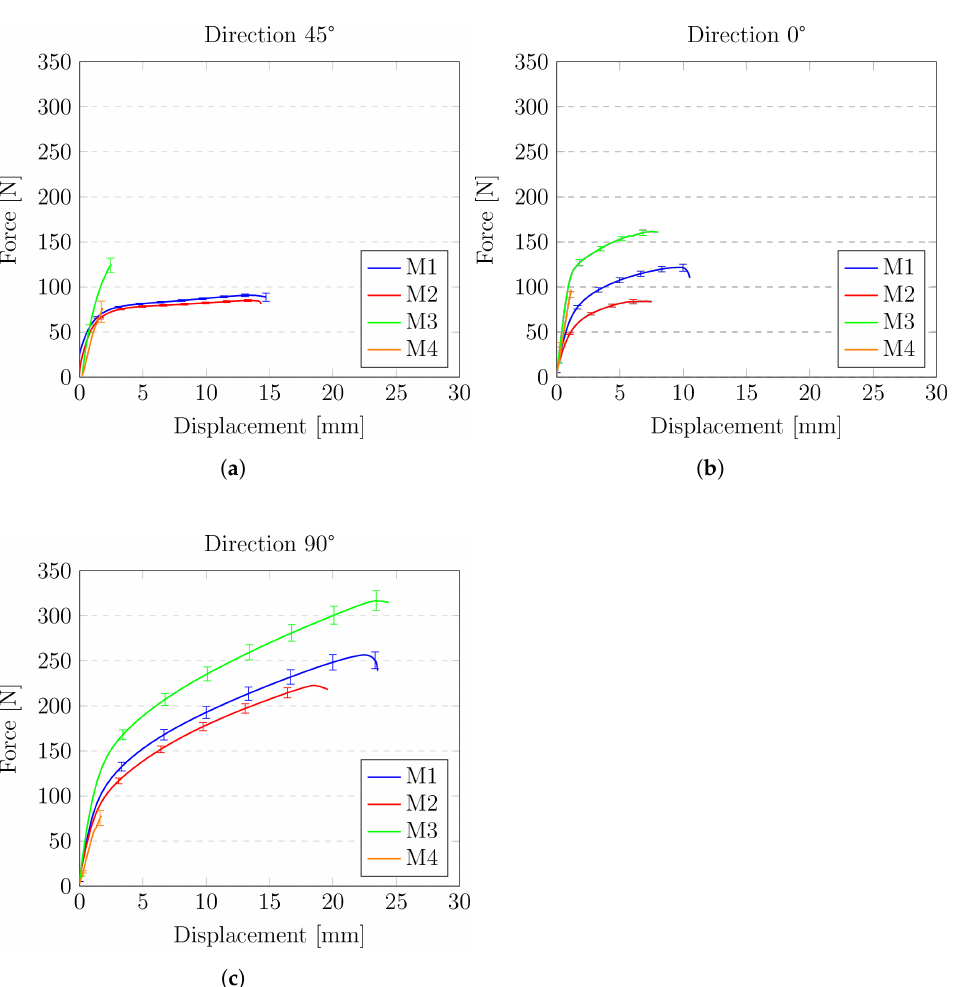
Figure 18a–d are focused on the comparison of the behaviour of a single material.